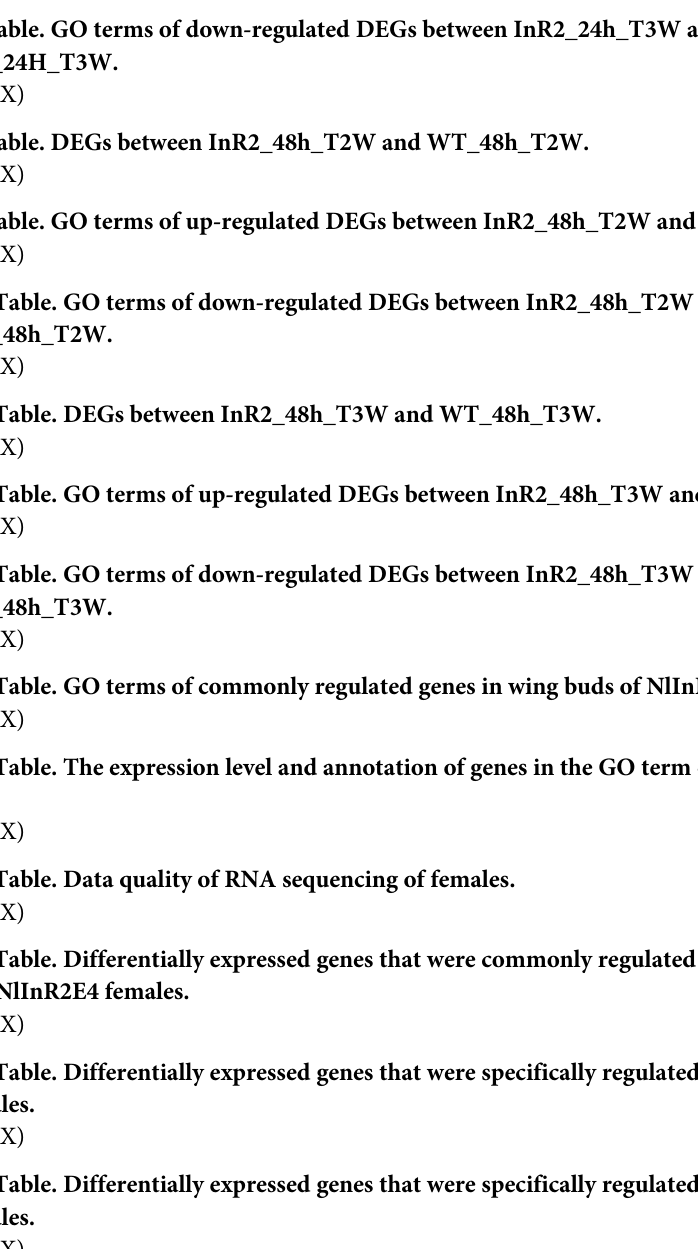
S4 Table. GO terms of down-regulated DEGs between InR2_24h_T2W and